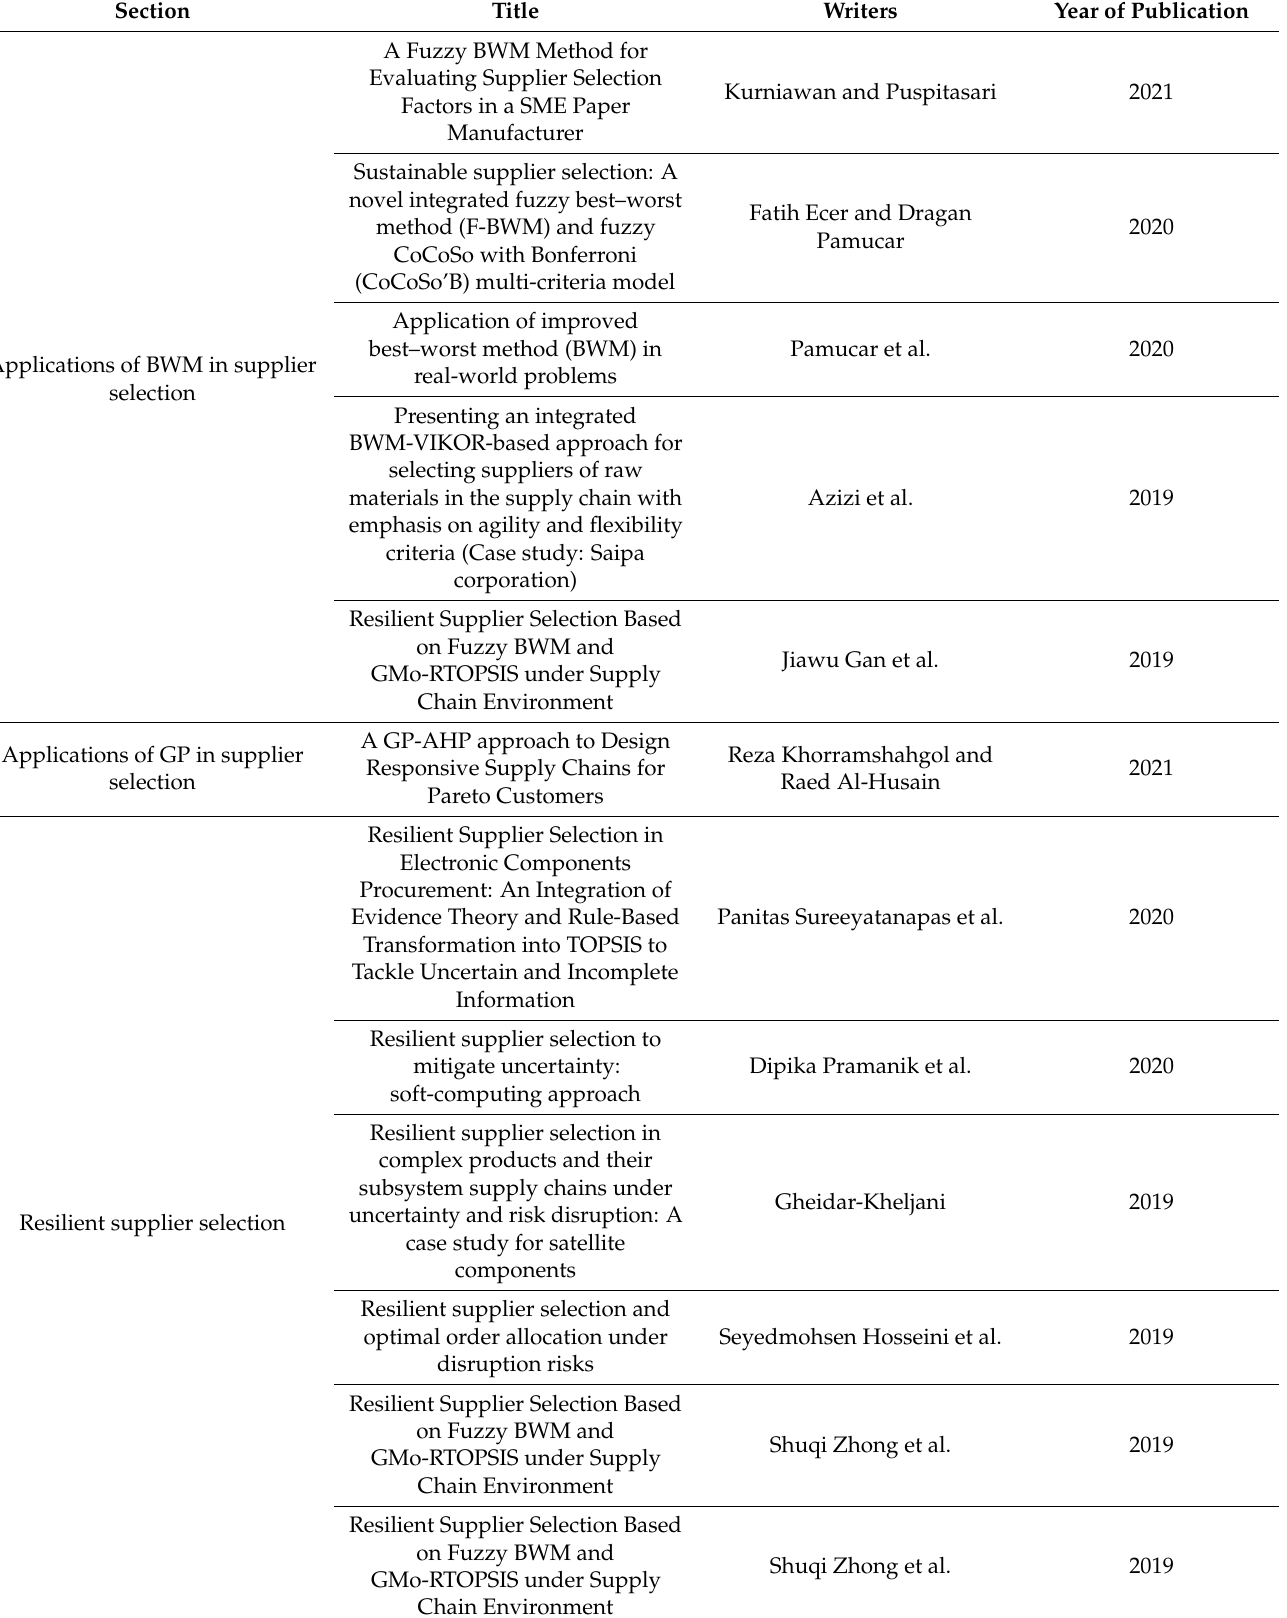
Table 2. Applications of BWM in supplier selection, applications of GP in supplier selection, and resilient supplier